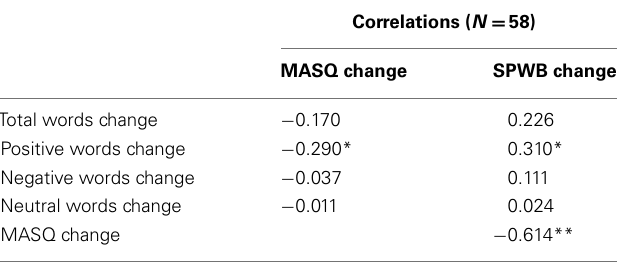
Table 2 | Pearson product–moment correlation coefficients.